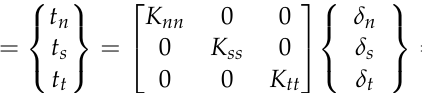
Figure 6. Traction-separation response.